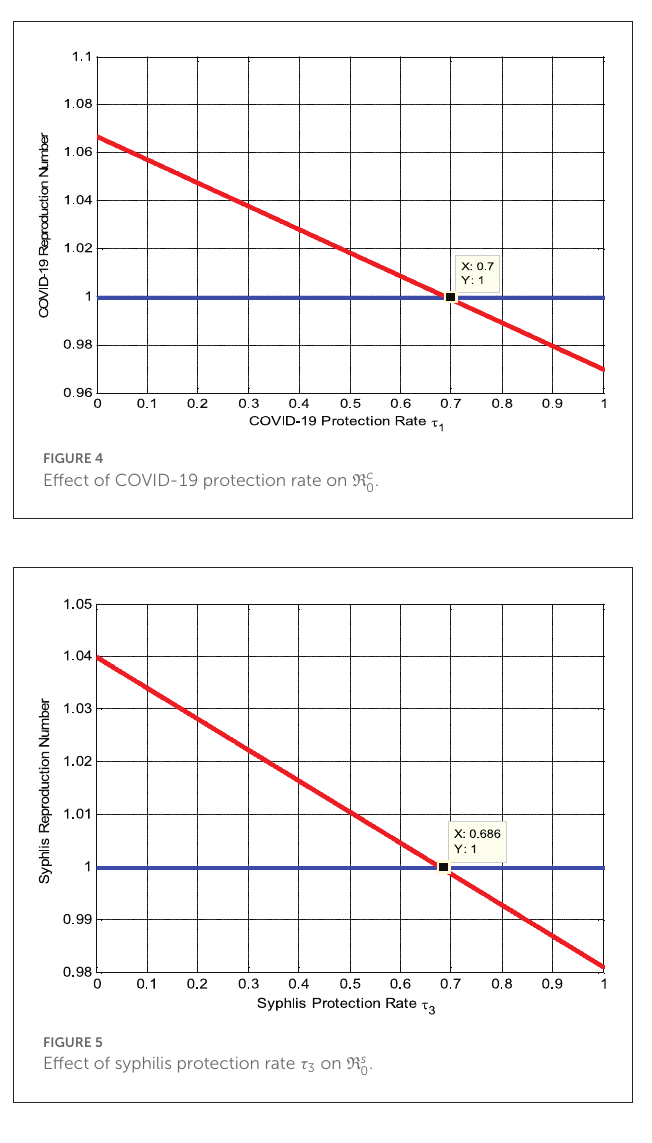
FIGURE7 Impact of treatment rate ρ on I c